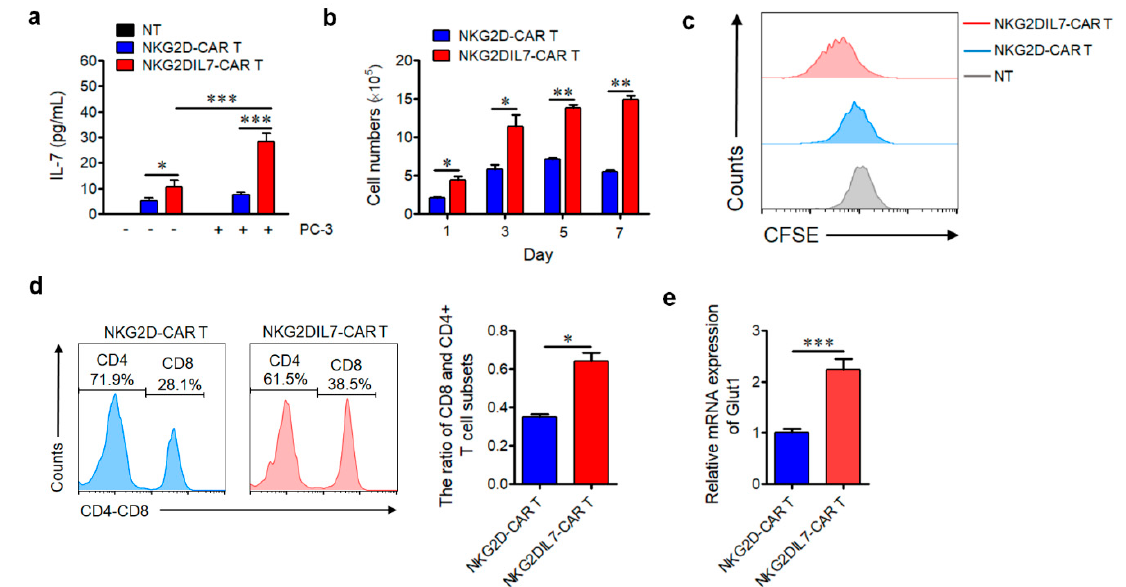
Figure 2. Co-expression of IL-7 enhances the proliferation of NKG2D-CAR T cells. ( a ) NKG2D-CAR or NKG2DIL7-CAR T cells were cultured in the absence or presence of PC-3 tumor cells at E:T ratio of 3:1 for 24 h without any exogenous cytokines, and the co-culture supernatants were detected for concentrations of IL-7 by ELISA. ( b ) Expansion of NKG2D-CAR and NKG2DIL7-CAR T cells after stimulation with tumor cells. The number of initial CAR T cells was 2.5 × 10 5 , and cell numbers were measured by Vi-CELL every other day. ( c ) Non-transduced, NKG2D-CAR and NKG2DIL7-CAR T cells were labeled with 5(6)-carboxyfluorescein diacetate succinimidyl ester (CFSE) before being stimulated by PC-3 tumor cells, the dilution of CFSE was determined by flow cytometry after 7 days of co-culture. ( d ) The flow cytometric analysis of the percentage and ratio of CD8 + and CD4 + T cells in vitro on 7th day after stimulation, the initial CD4 and CD8 percentages were the same. ( e ) E ff ector and targeT cells were co-cultured at E:T ratio of 2:1 for 24 h, and the expression of Glut1 was measured by quantitative real-time PCR. * p < 0.05, ** p < 0.01, *** p < 0.001. Data are representative of 4 donors and have been gated on NKG2D + T